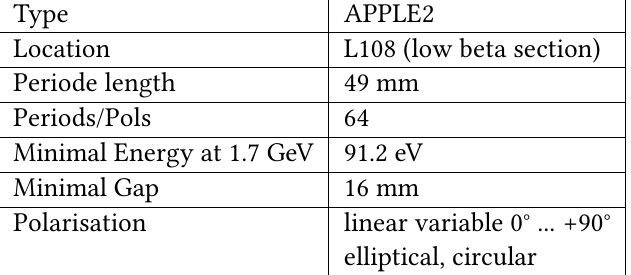
Table 1: Parameters of insertion device UE49.